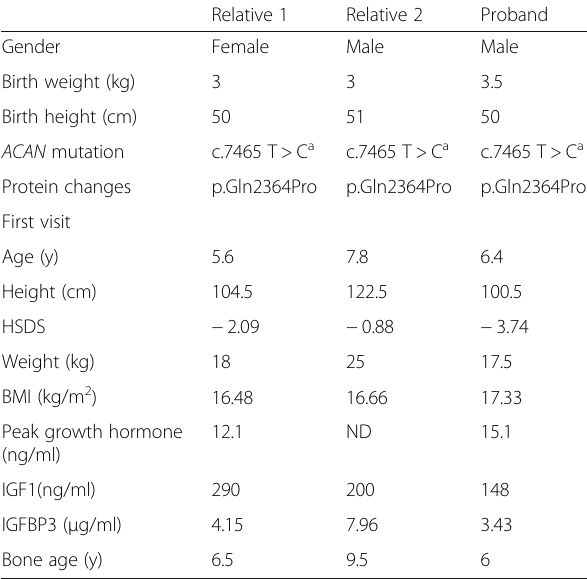
Table 1 Characteristics of children with ACAN variant treated with growth hormone